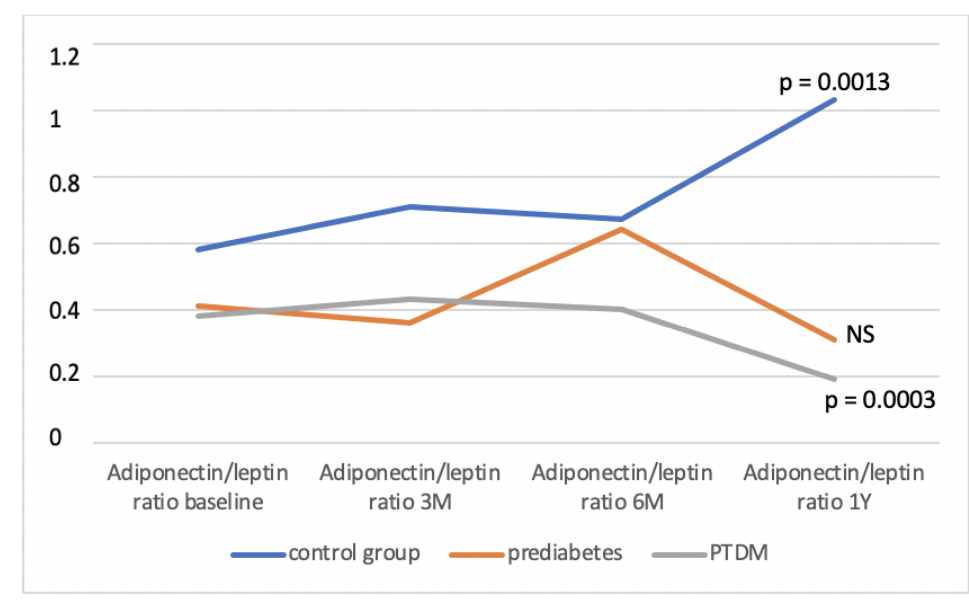
Figure 2. Development of the A/L ratio in observed group during the monitored period. NS — non- significant, M — month, Y — year, PTDM — post-transplant diabetes mellitus.